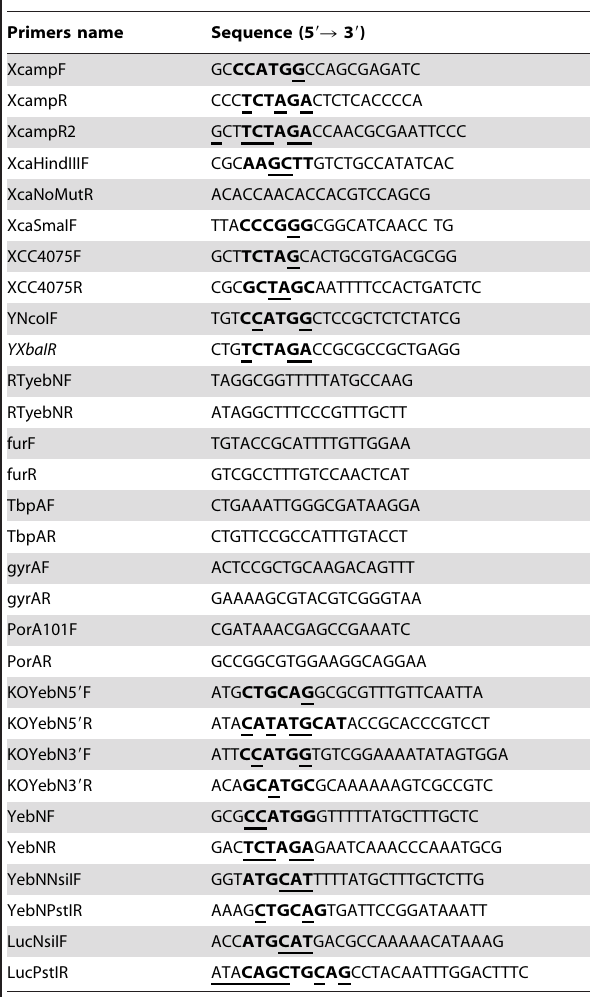
Table 1. Oligonucleotide primers used in this